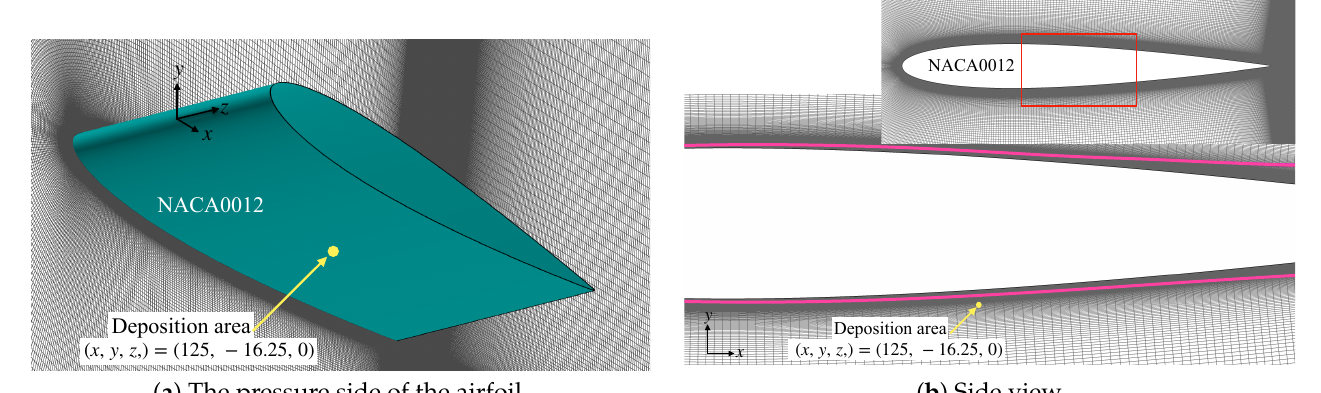
Figure 9. Deposition area. ( a ) The center of the string of plasma beads was set as ( x , y , z ) = ( 125, − 16.25, 0 ) mm. The magenta line in ( b ) indicates ¯ u x / u ∞ = 0.99, which is the boundary